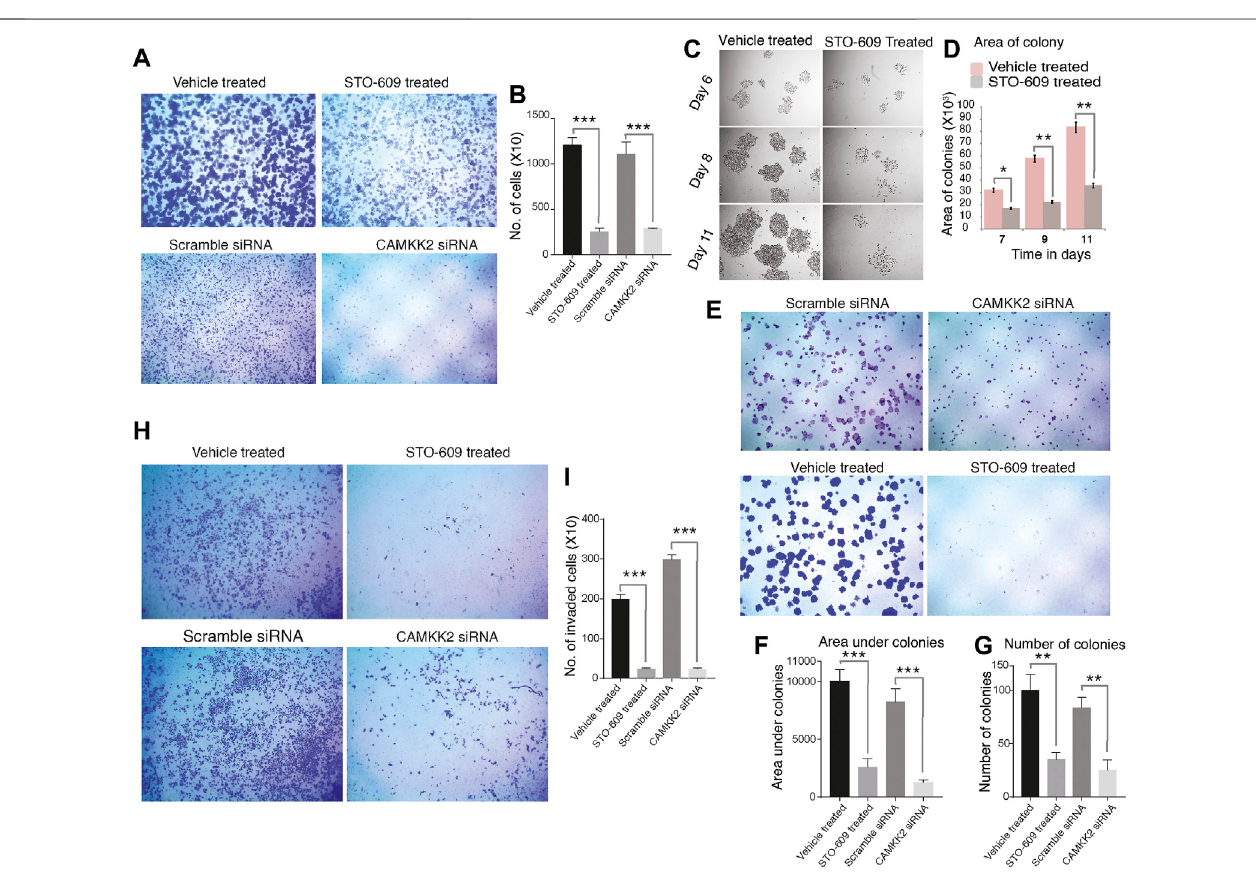
FIGURE5| Inhibitionorsilencing ofCAMKK2 leadstoreducedcellular proliferation,invasion,migration, andcolonyformationinAGScells. (A) Cellularproliferation ofAGScellsuponCAMKK2inhibition withSTO-609 orsilencingbyCAMKK2siRNA. Proliferatedcellswerestainedwithcrystalvioletandvisualizedunderamicroscope at 1× magni fi cation. (B) Bar diagram depicting cellular proliferation activity of AGS cells upon CAMKK2 inhibition/silencing (*** p < 0.001). (C) Representative images of coloniesobtainedfrom AGScellsuponSTO-609 treatment;DMSO usedasvehiclecontrol. Photographs weretakenatindicatedtimepointsat 10×magni fi cation. (D) A bar diagram depicts colony size in AGS cells upon CAMKK2 inhibition (* p < 0.05, ** p < 0.01). (e) Colony formation assay of AGS cells upon CAMKK2 inhibition by STO-609 or silencing with CAMKK2 siRNA. Colonies formed were stained with crystal violet to visualize under a microscope (1× magni fi cation). (F,G) Results obtained from colony formation assay are represented as a bar chart showing colony number and area under colonies (** p < 0.01, *** p < 0.001). (H) Invasion assay to see the cellular invasion of AGS cells following treatment with STO-609, with DMSO used as vehicle control, and CAMKK2 siRNA or Scramble siRNA. Invasion assays were carried outinatranswellsystemusing Matrigel-coated fi lters,andmigratedcellstothelowerchamber werecounted. Cellswerestainedwithcrystalviolet andvisualized in a microscope (10× magni fi cation). (I) Graphical representation of invasive ability of AGS cells upon CAMKK2 inhibition or silencing (*** p < 0.001).